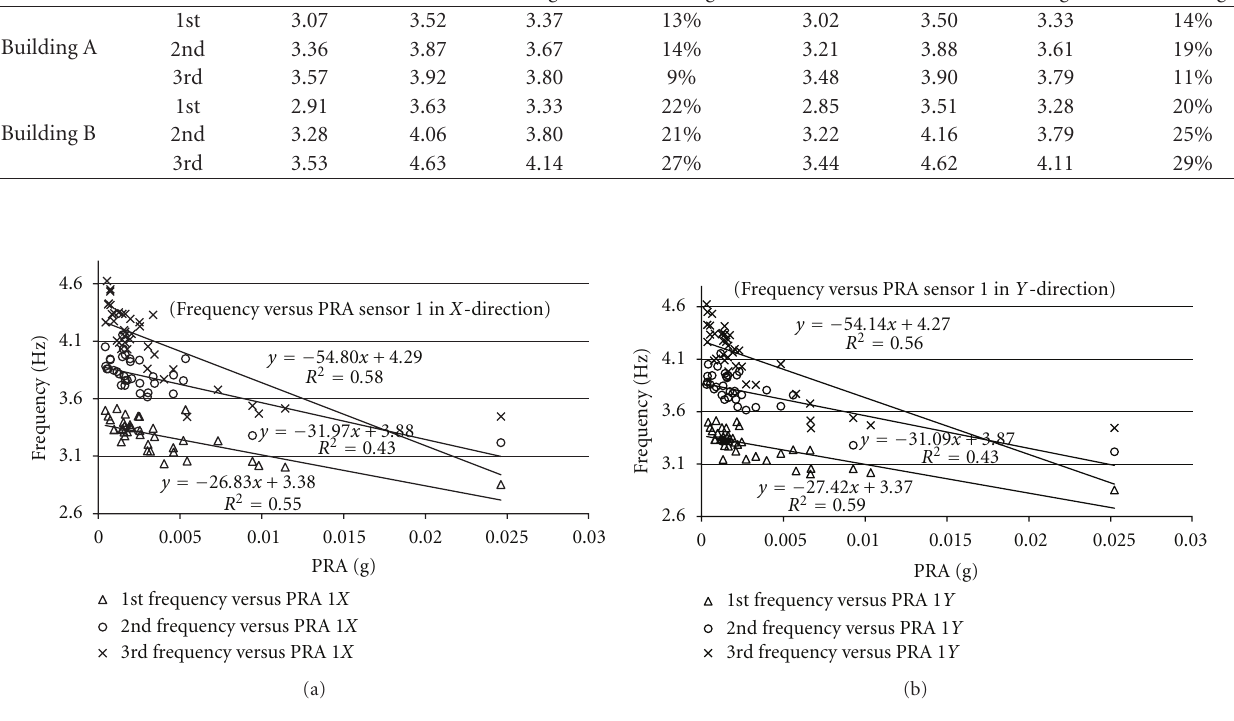
Table 4: Summary of identified frequencies for buildings A and B for pseudoflexible and flexible base models. Building